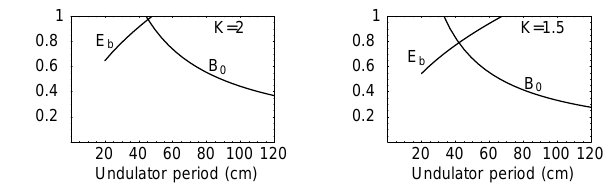
FIG. 2. Beam energy E b in units of 100 GeV and peak un- dulator field B 0 in units of 10 T as a function of the undulator period for two values of undulator parameter K